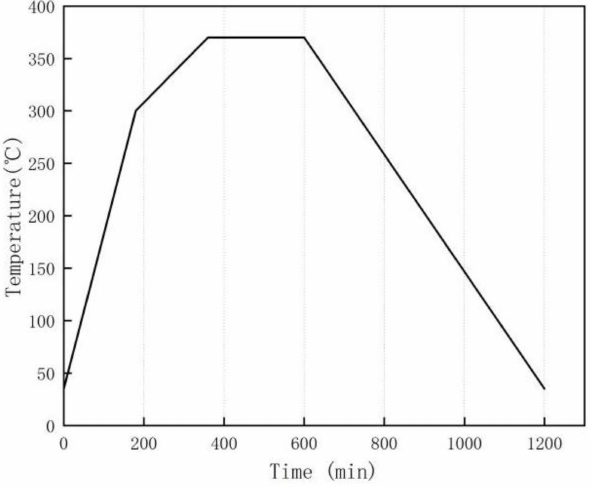
Figure 1. Sintering